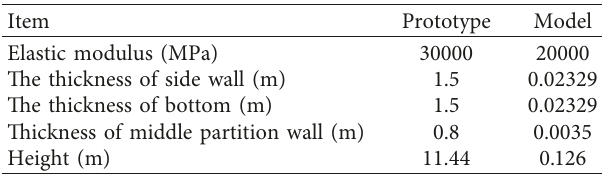
Figure 2: Geographic location diagram. Table 1: Model and prototype parameter comparison table.